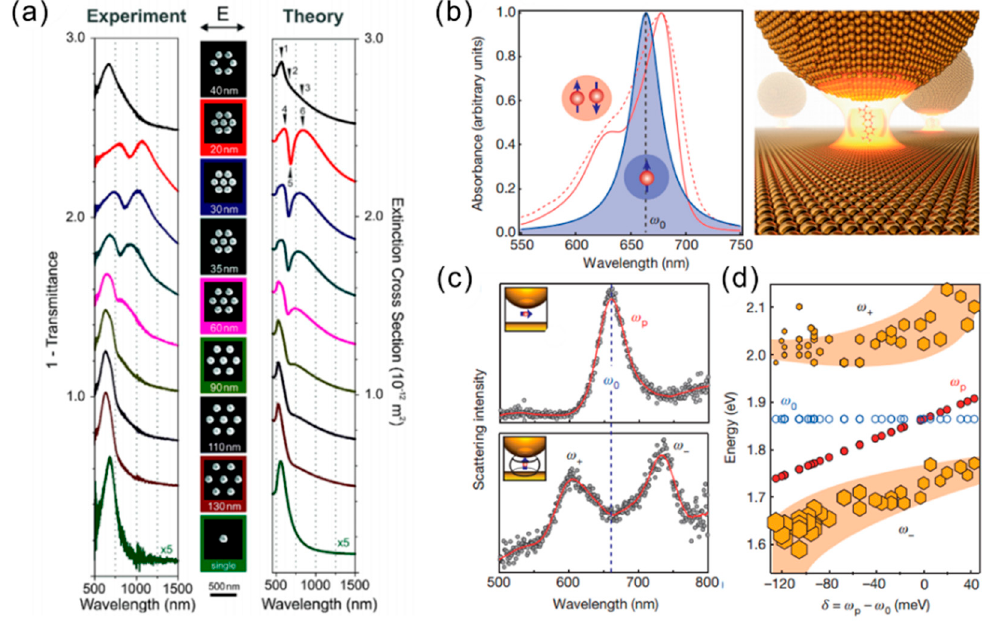
Figure 2. ( a ) Extinction spectra of a gold monomer, a gold hexamer, and gold hepatmers with different interparticle gap separations. Adapted from [24], with permission from © 2010 American Chemical Society. ( b ) Plasmonic nanocavity containing a dye molecule. The schematic diagram illustration of a methylene-blue molecule in cucurbit[7]uril, in the NP on-mirror geometry. ( c ) Scattering spectra resulting from isolated NP on-mirror according to the orientation of the emitter (the methylene-blue dye; see insets). Split peaks result from the strong interaction between the emitter and the plasmon. ( d ) Resonant positions of methylene-blue, plasmon, and hybrid modes as a function of extracted detuning. Adapted from [25], with permission from © 2016 Springer